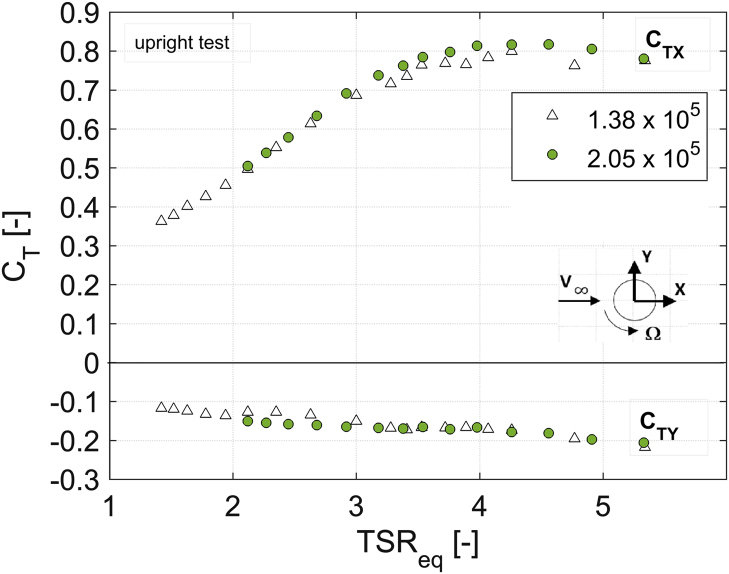
CTX and CTY curves for the upright rotor at 200 rpm (Re=1.38×105) and 300 rpm (Re=2.05×105).